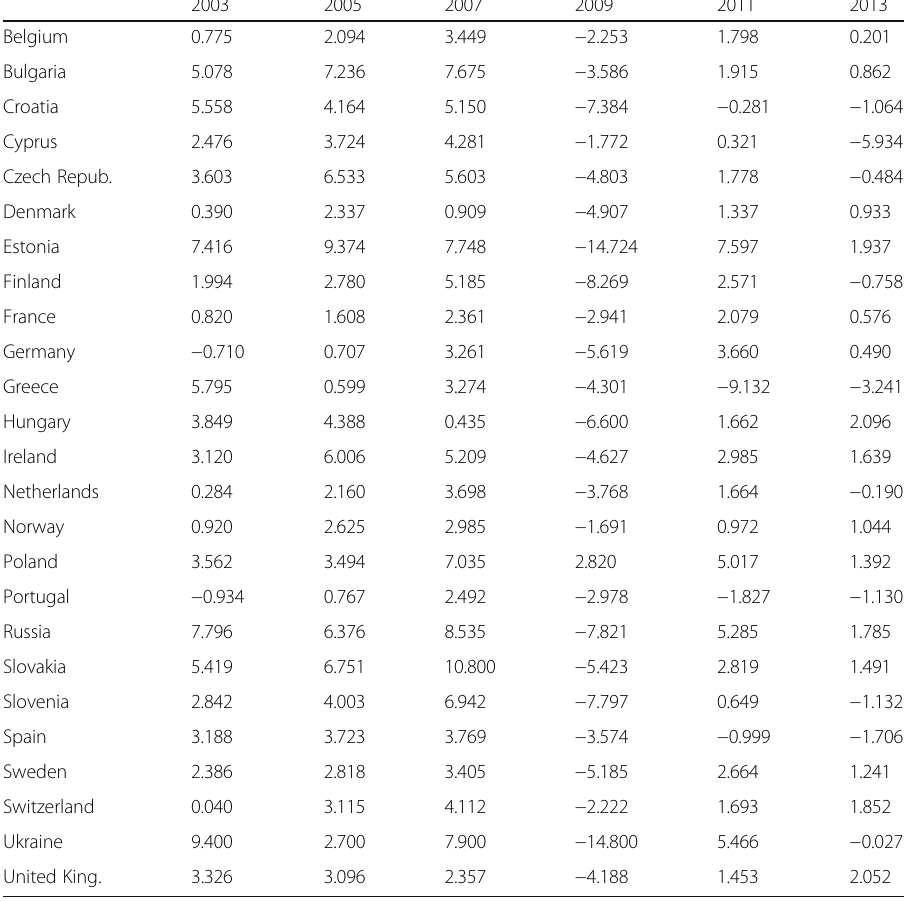
Table 1 GDP growth (in percent of